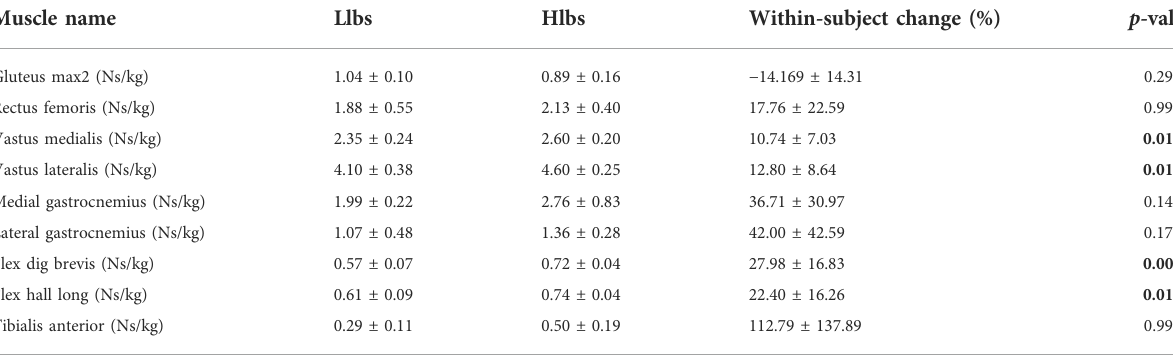
TABLE 4 Impulse during stance phase in the Llbs and the Hlbs shoes (mean ±